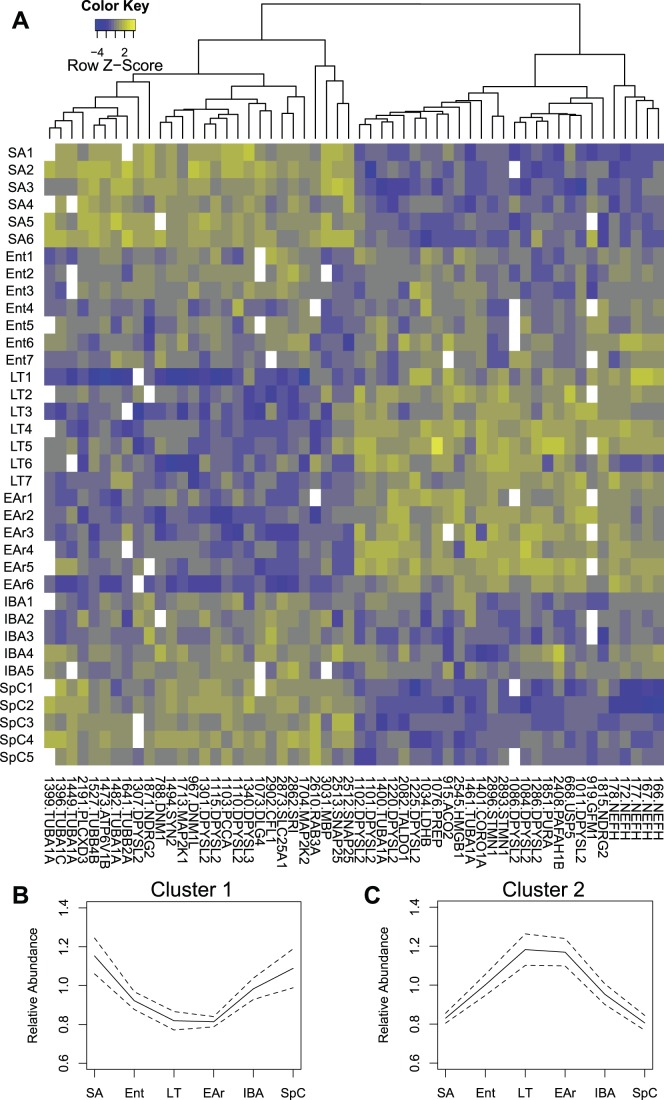
Forebrain proteome heat map.The forebrain proteome of cold-Tb ground squirrels demonstrated a reciprocal abundance pattern to euthermic animals. (A) Heat map y-axis: Individual ground squirrels grouped by state. Heat map x-axis (bottom): Protein spots (Spot Number.GeneID) that differed significantly by hibernation state (ANOVA q) and identified by LC-MS/MS were hierarchically clustered (X-axis (top): dendrogram). Blank squares in the heat map represent samples in which a given protein spot was not recovered. (B & C) Means with 95% confidence intervals are plotted for the two reciprocal clusters.